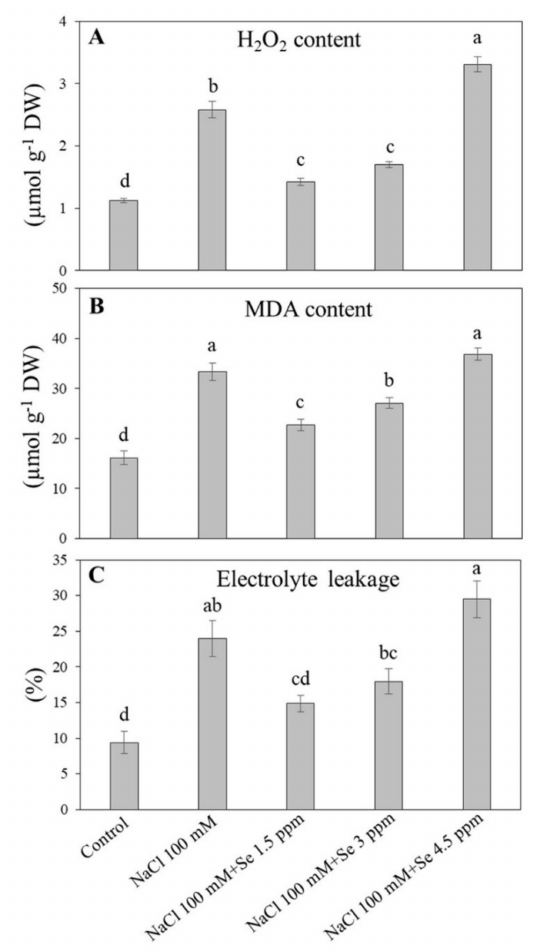
Figure 2. E ff ect of selenium (Se) fertilization on ( A ) hydrogen peroxide (H 2 O 2 ); ( B ) malondialdehyde (MDA) content; and ( C ) electrolyte leakage (EL) in leaves of black gram plants under salt stress. Values are mean ± standard error ( n = 3). Di ff erent letters in vertical columns show a significant di ff erence. A comparison of mean was confirmed by LSD at p <